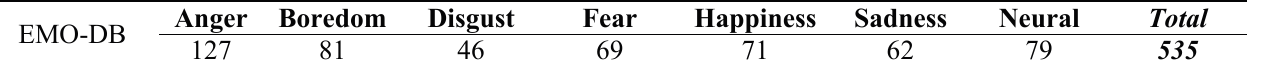
Table 2. Distribution of emotional sentences for EMO-DB.